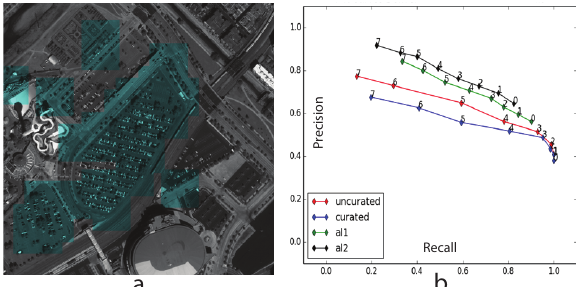
Figure 8: (a) Visualization of the parking lot detection results in Denver area. (b) P-R curves for different types of